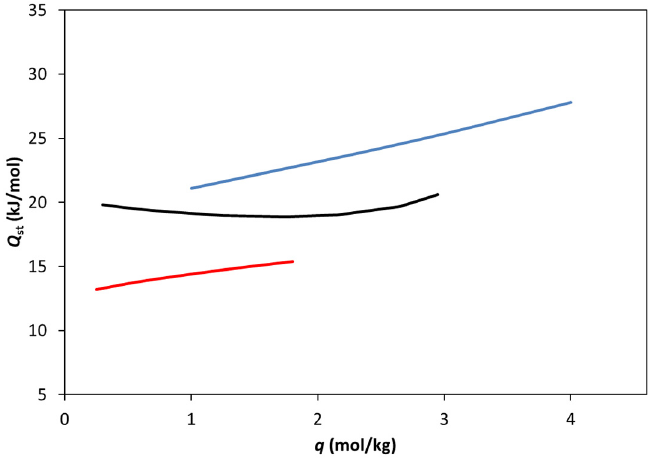
Figure 11. CO 2 (blue), CH 4 (black), and N 2 (red) isosteric heats of adsorption, 𝑸 𝐬𝐭 , as a function of loading, q .